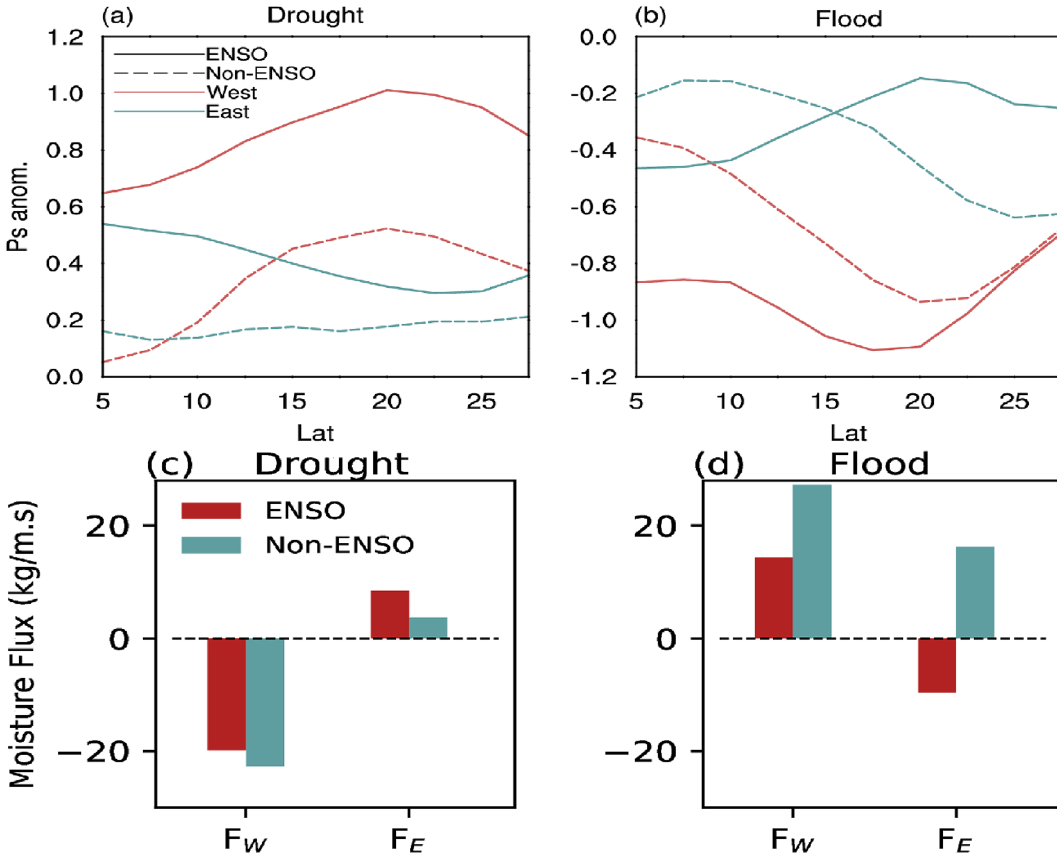
Figure 7. Drought and flood during ENSO and Non-ENSO years. The latitudinal profile of surface pressure variation (hPa) along the western (red) and eastern (blue) boundary for ENSO (solid) and Non-ENSO (dashed) related ( a ) drought and ( b ) flood, respectively. ( c, d ) Shows the relative contribution of zonal moisture fluxes ( F W and F E ) associated with drought and flood over Indian region during ENSO (red) and Non-ENSO (blue) years. This figure was created using NCL version 6.4.0 (https:// www. ncl. ucar.